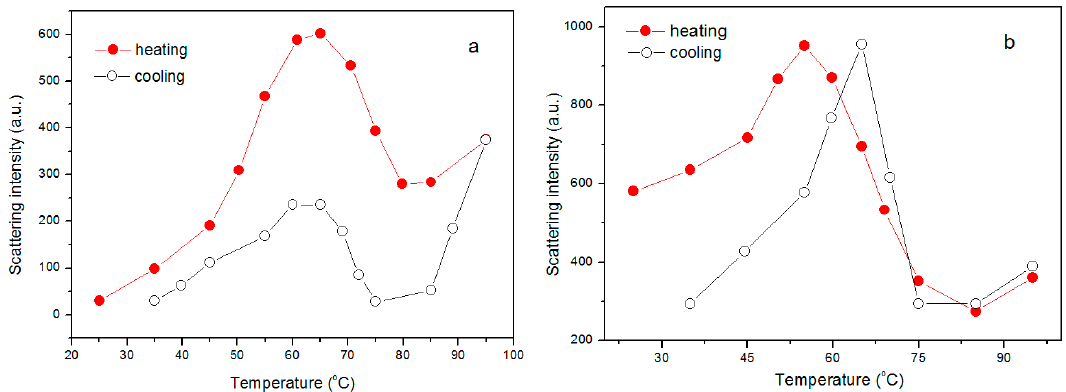
Figure 7. Scattering intensity of 0.6 and 1 g·L − 1 mPEG-maleic rosin solutions at 390 nm as a function of temperature during one heating and cooling cycle: ( a ) 0.6 g·L − 1 ; and ( b ) 1 g·L − 1 .